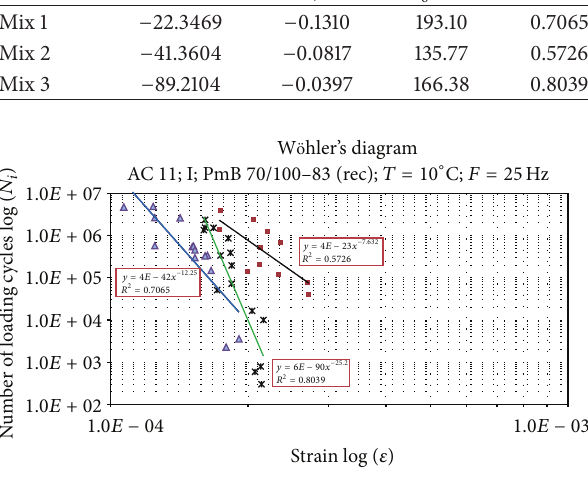
Figure 8: Fatigue curves for Mix